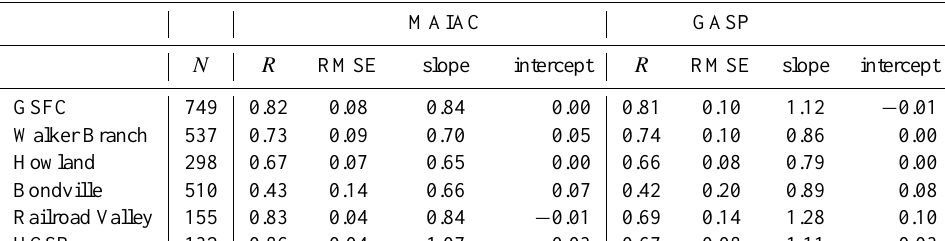
Table 3. Comparisons between MAIAC vs. AERONET and GASP vs. AERONET with one-to-one correspondence between MAIAC and GASP AOD.